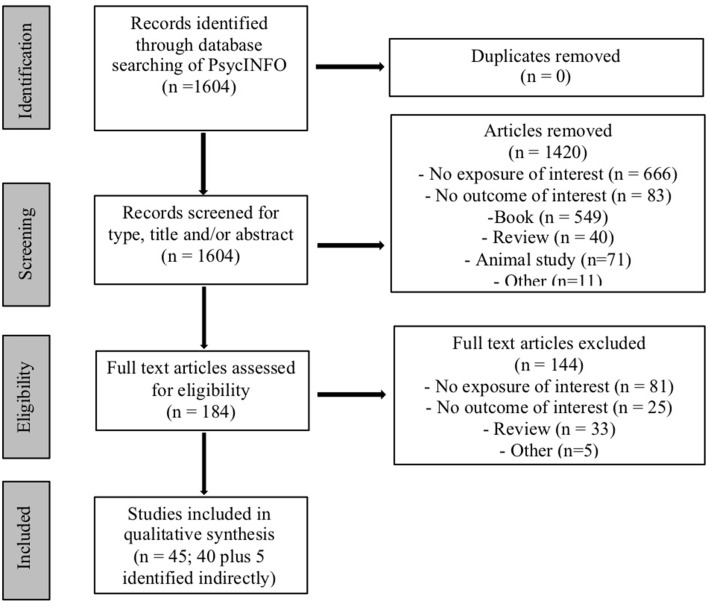
Flowchart of search strategy.